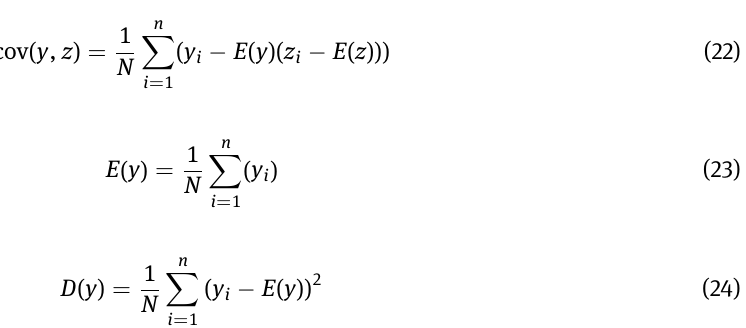
Table 1 shows the correlation coefficients between the R, G, and B channels of the encrypted color